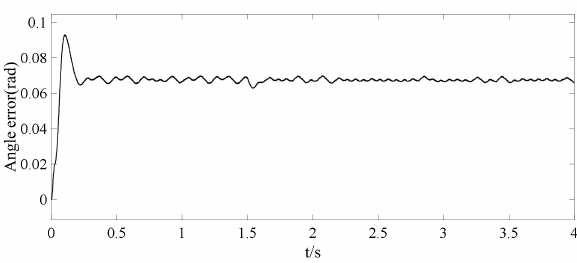
Figure 12. Rotor position angle error waveform at 500